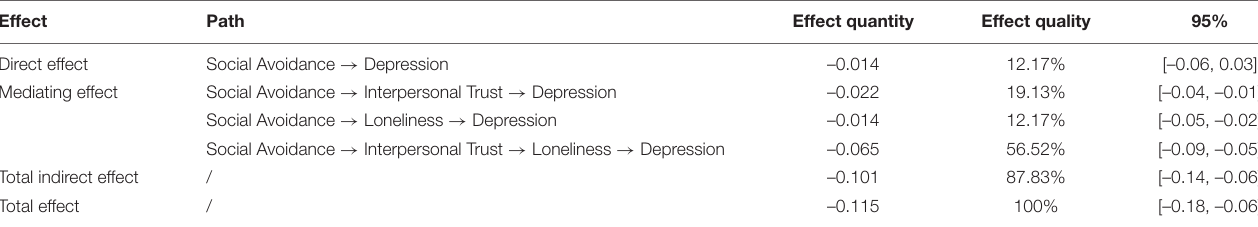
FIGURE 1 | Chain-mediation pathway diagram. *** P < 0.001. TABLE 2 | The 95% confidence interval of the mediating effect test and deviation